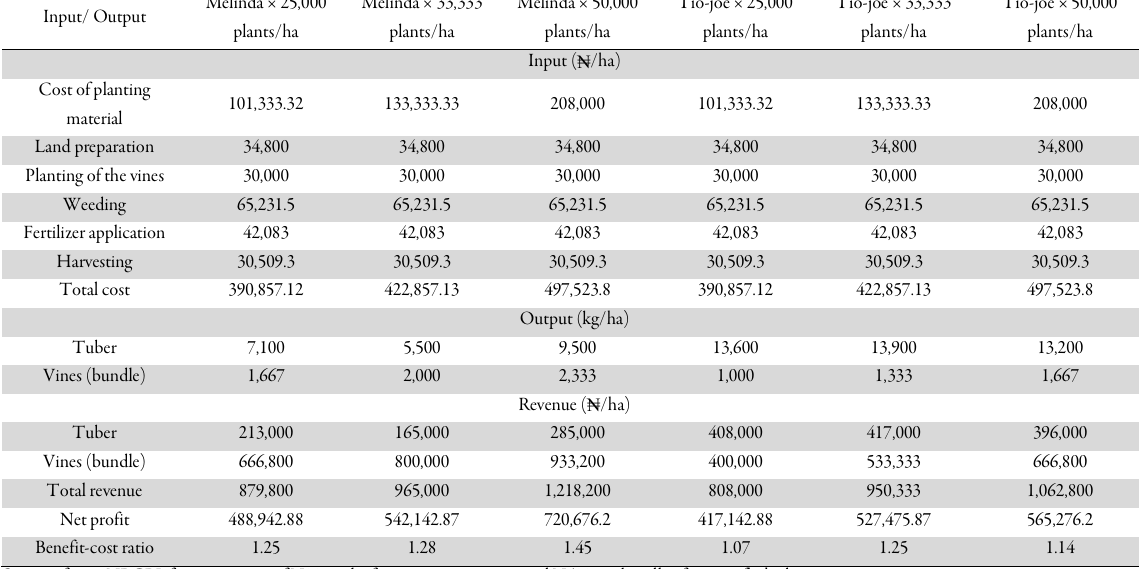
Table 2. Benefit cost ratio analysis of the orange-fleshed sweet potato at 2015 cropping